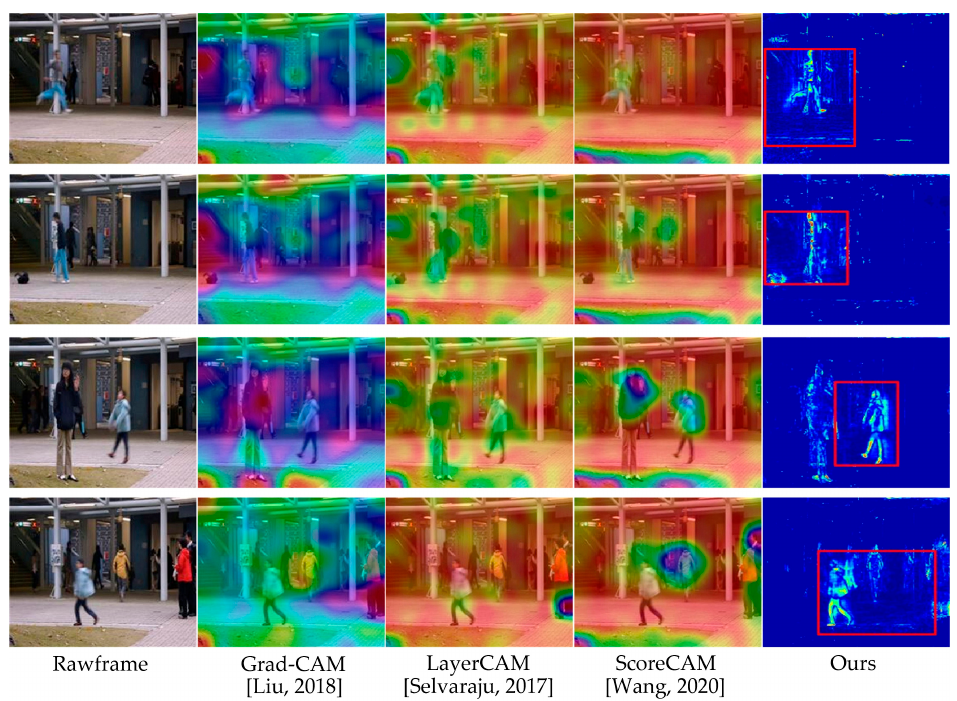
Figure 5. Comparison with other saliency methods on Avenue dataset. From left to right: original abnormal video frame, Gradient-CAM saliency [7], LayerCAM saliency [44], Score-CAM saliency [48], and our method. The bounding box explains the strange objects learned by the approach.